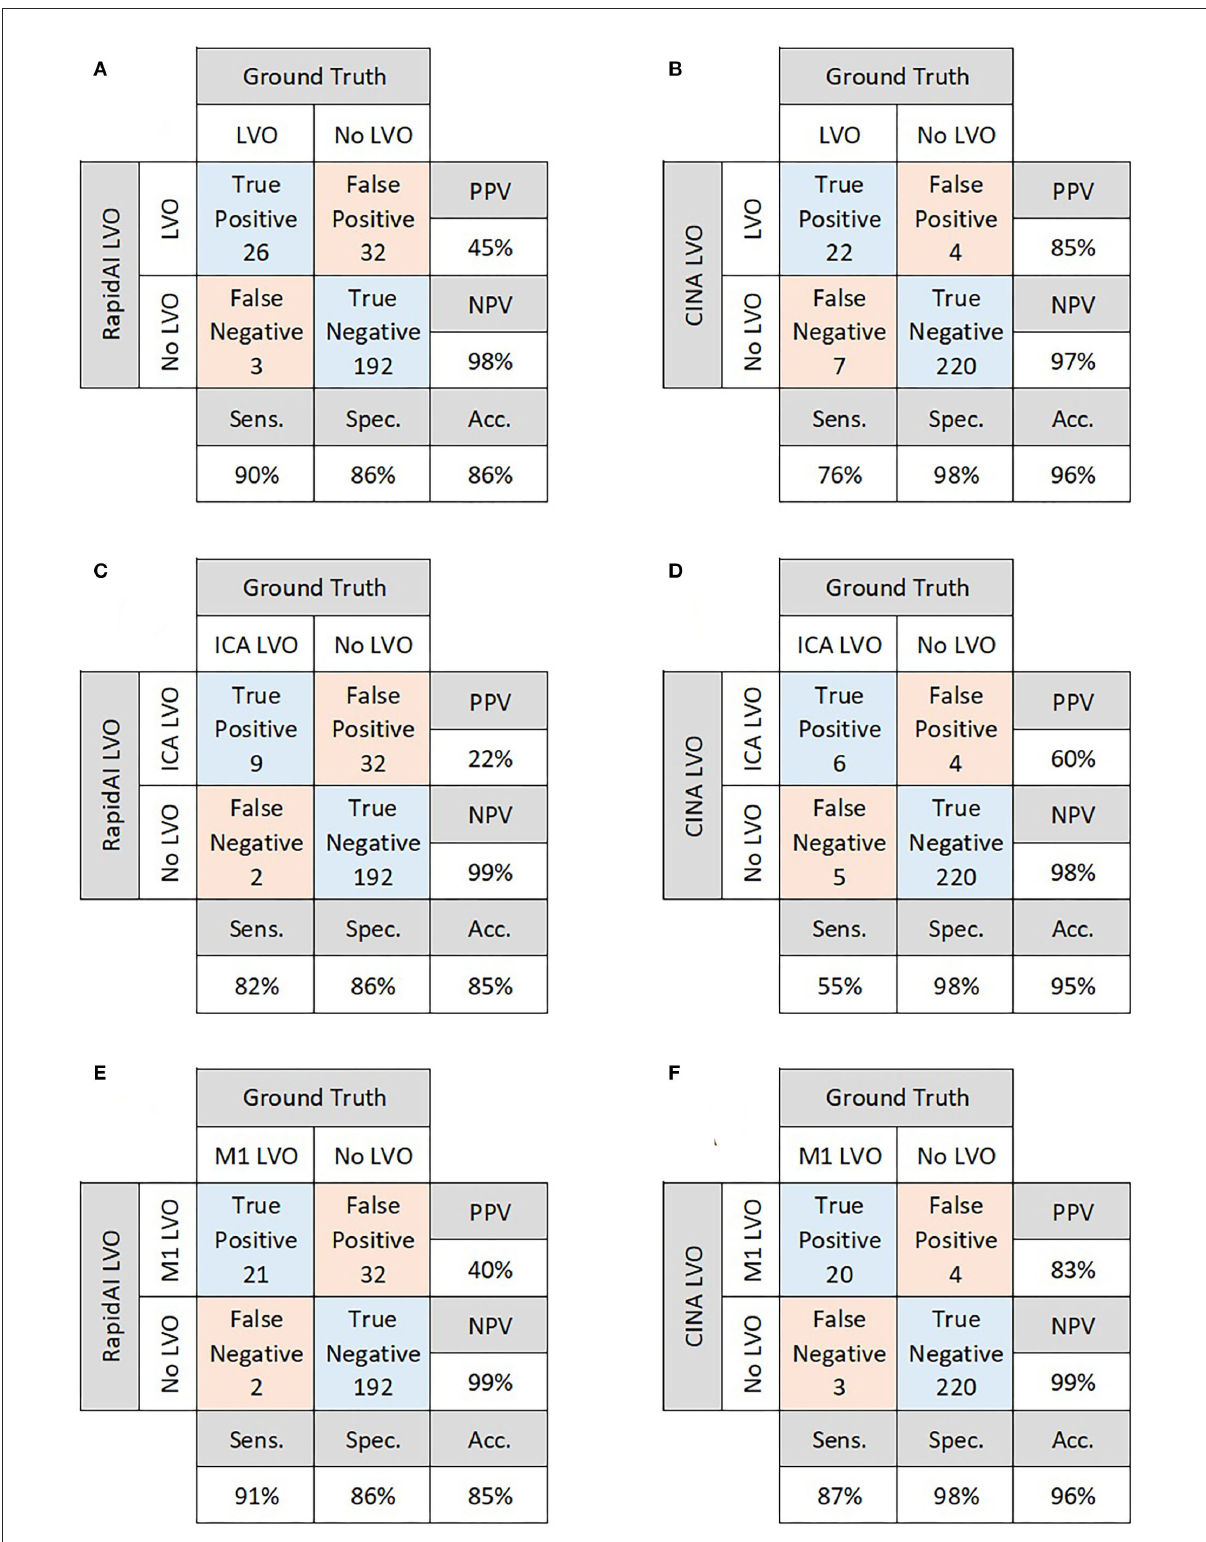
FIGURE2 Confusion matrices for overall performance of RAPID LVO (A) and CINA LVO (B) , ICA occlusions detected by RAPID LVO (C) and CINA LVO (D) , and M1 MCA occlusions detected by RAPID LVO (E) and CINA LVO (F)